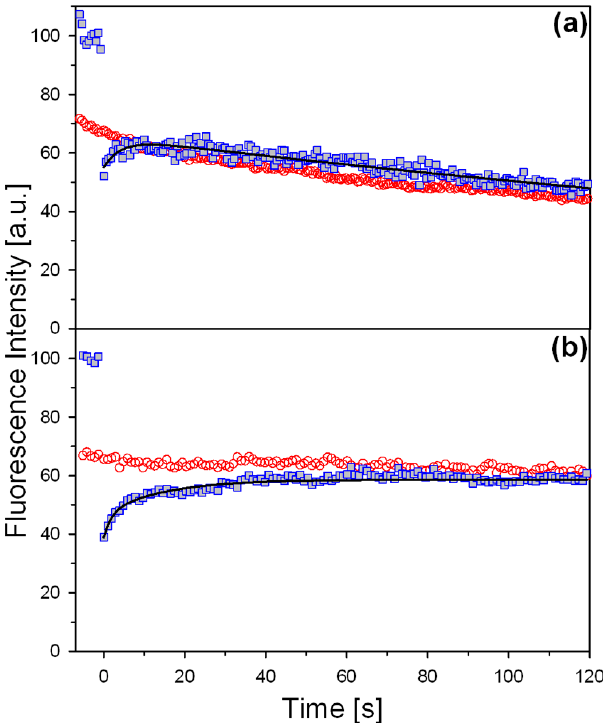
Figure 4. Fluorescence recovery after photo-bleaching (FRAP) curves. Graphs showing the recov- ery of fluorescence as a function of time of ( a ) M Ma , ( b ) D Ma . Each panel shows a Scheme 4 (panel ( a )) or 3 (panel ( b )), and a control area from a non-bleached region of interest showing acquisitional bleach (red circles). The intensity axis has been normalized to the pre-bleach average.